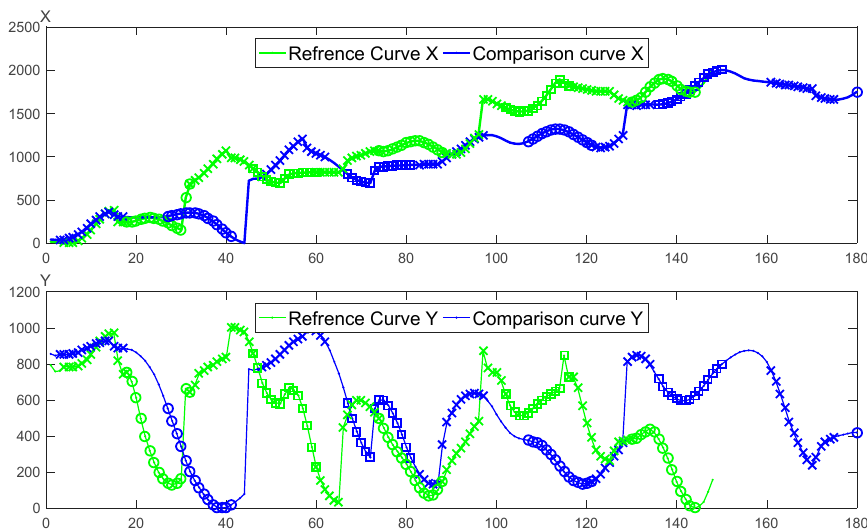
Figure 7. The matching results of the genuine and the forged signatures.